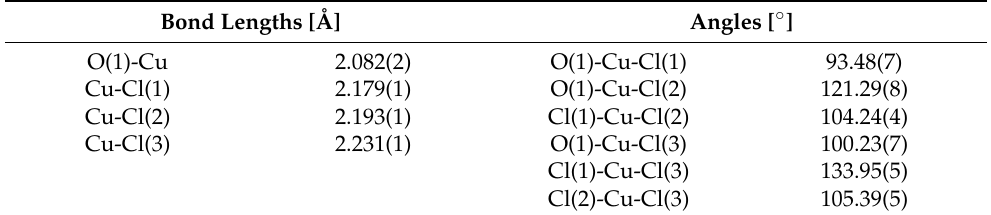
Table 2. Bond lengths [Å] and angles [ ◦ ] around copper in for trichlorosunitinibcopper(II) (CuSun).